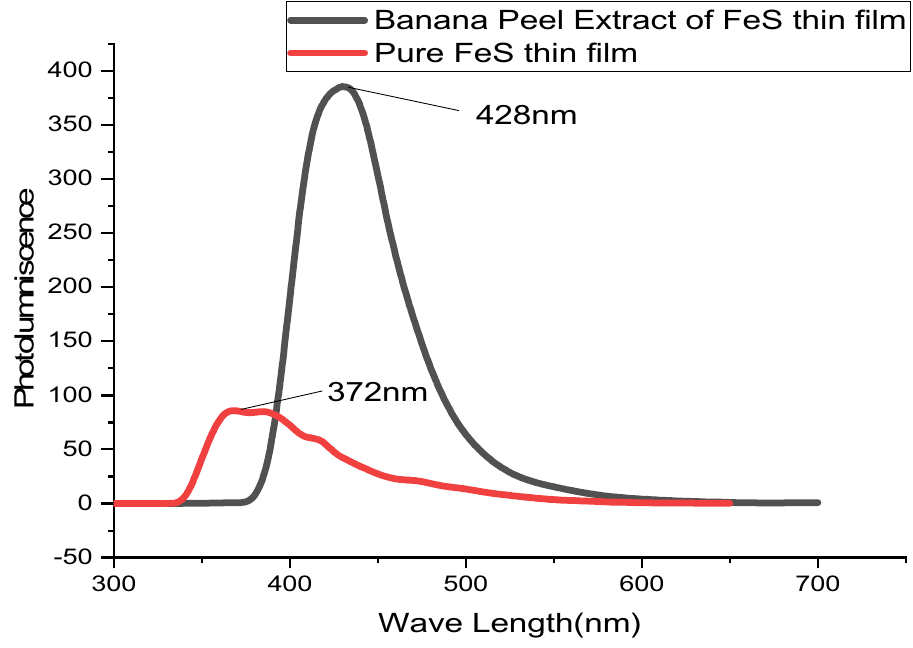
Figure 4. Photoluminescence spectral FeS thin films deposited as nanocrystalline FeS from banana leaf extraction and pure FeS thin